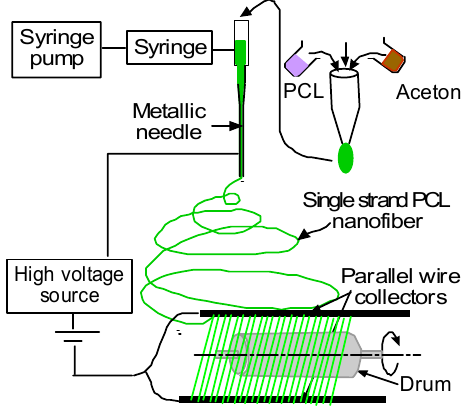
Figure 1. Schematic representation of an electrospun nanofiber production system that can be set up to produce PCL.